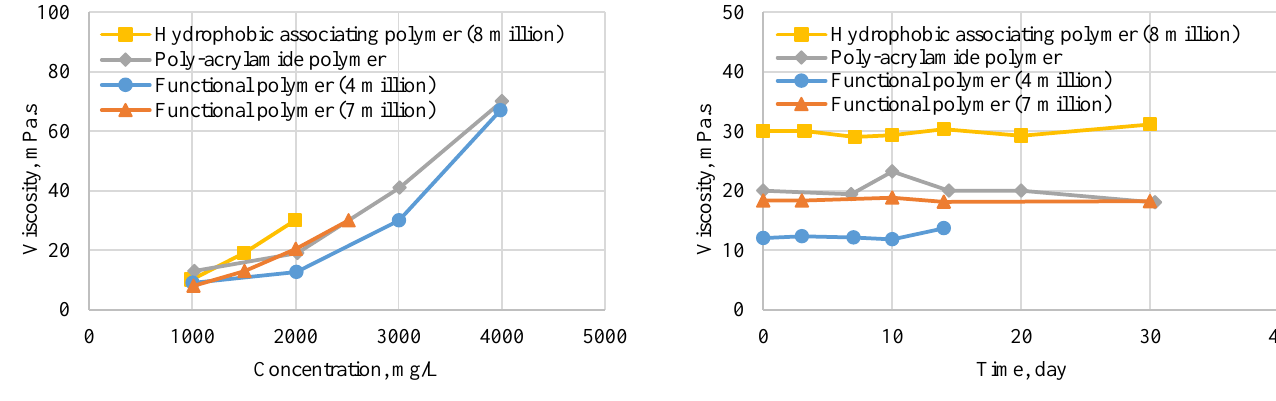
Figure 2—Comparison of viscosity enhancement between hydrophobic associating polymer and other polymers.